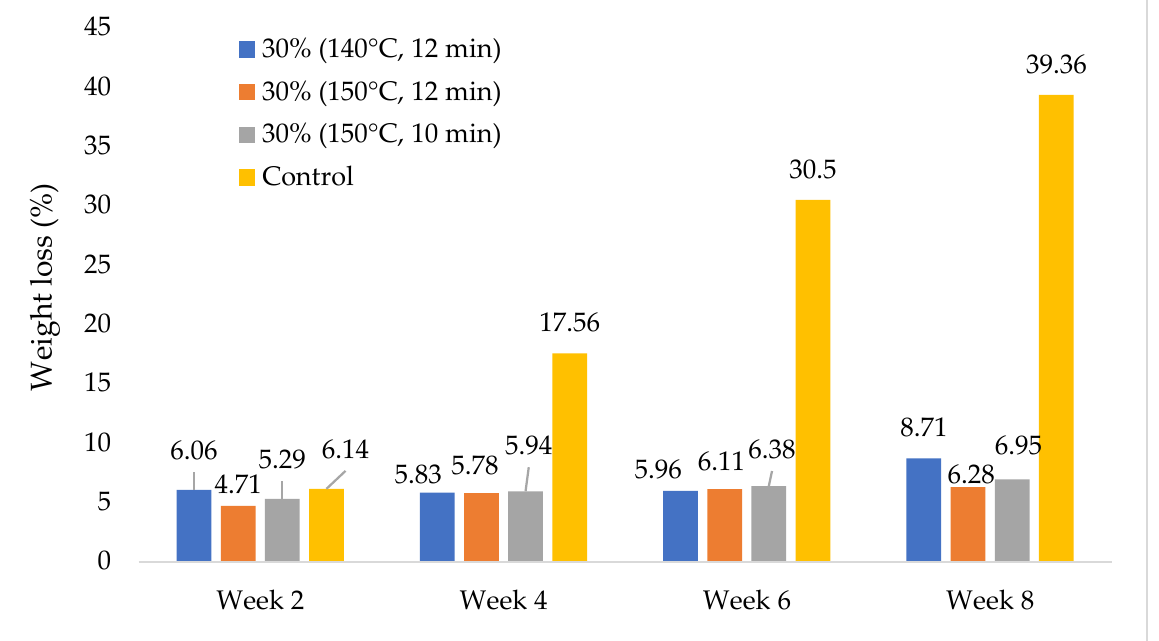
Figure 4. Weight loss of samples after 2-, 4-, 6-, and 8-weeks exposure to white rot fungi.